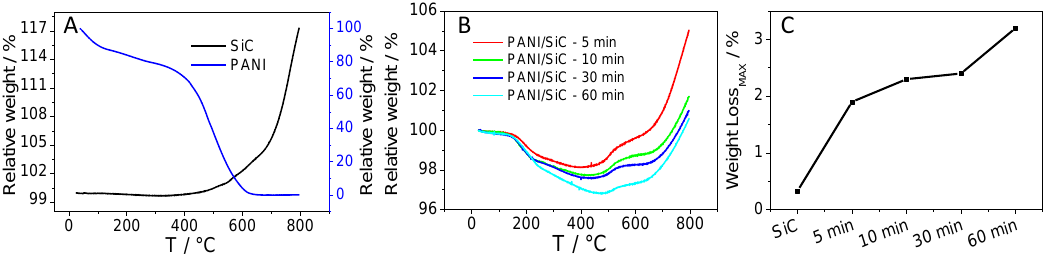
Figure 3. Weight loss curves registered during the thermogravimetric analysis (TGA) for ( A ) silicon carbide (SiC) and polyaniline (PANI); ( B ) and the various SiC/PANI hybrids; ( C ) a comparison of the PANI content of the various SiC/PANI hybrids as derived from TGA.